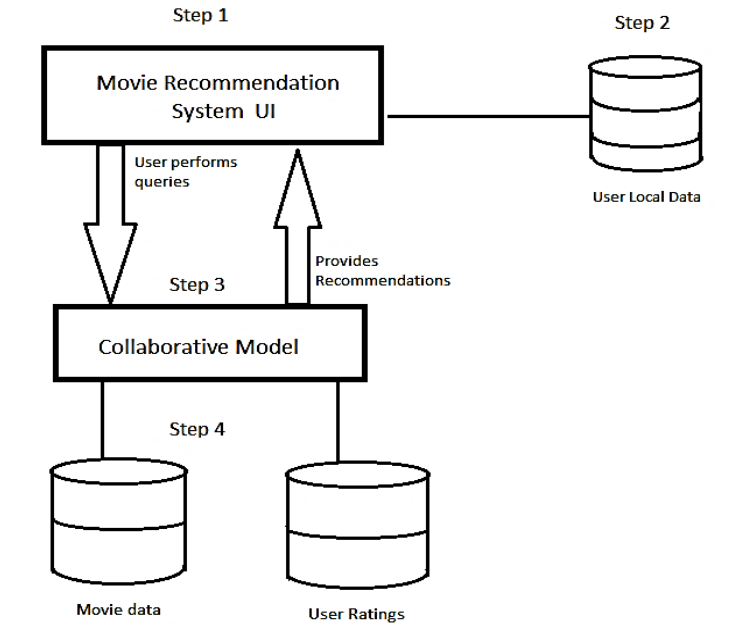
Figure 2. The architecture of movie recommendation